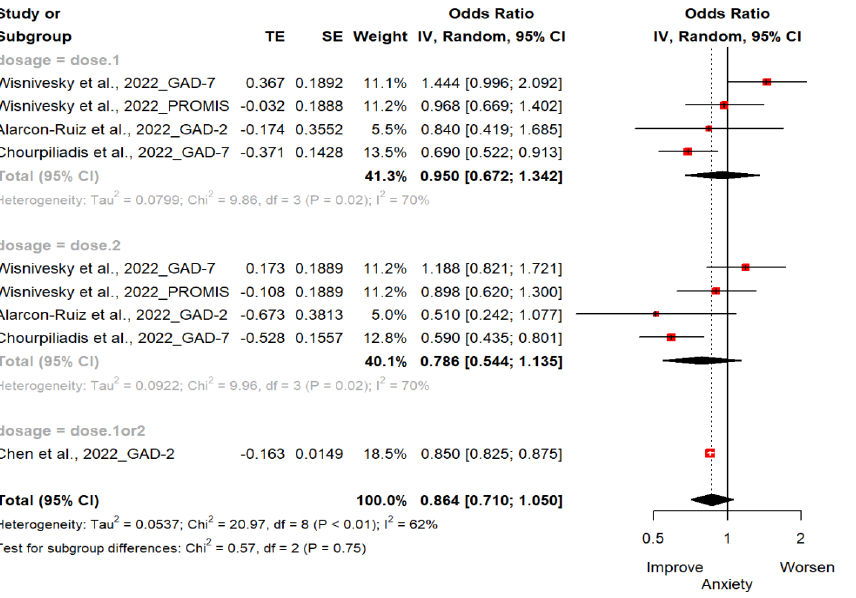
Figure 4. Forest plot diagram showing the effect of COVID-19 vaccination on distress. Mean difference; CI, confidence interval. [23,24] 3.5. Moderator Analysis We considered potential moderating roles of the following variables using meta- regression and meta-ANOVA models: number of participants; follow up period; age; sex; race; measures; marital status; COVID-19 history. Table 3 provides an overview of the moderator analyses of depression and anxiety.